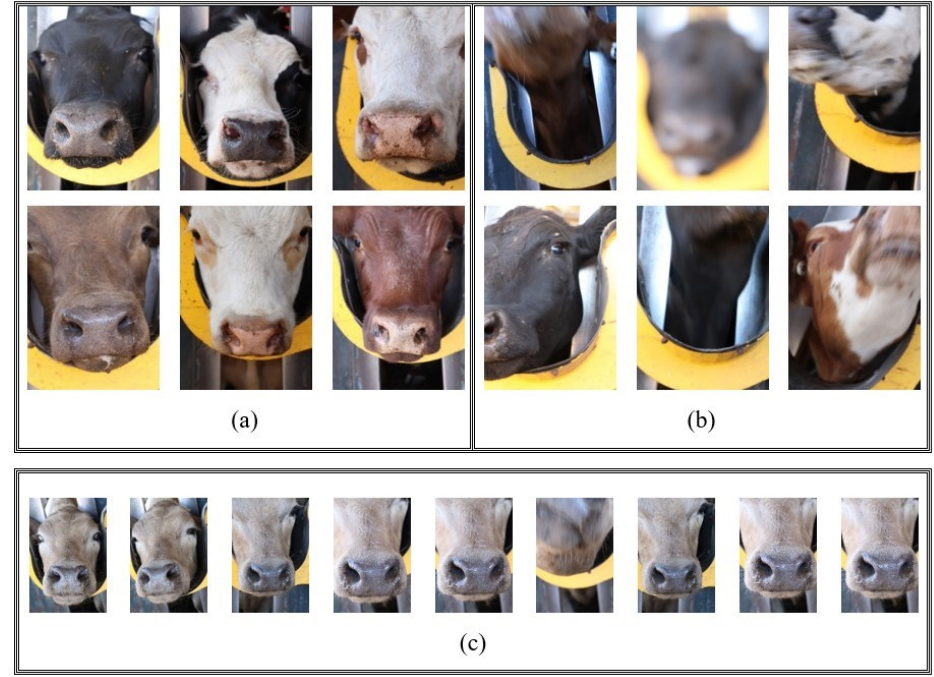
Figure 1. Samples of cattle face images: ( a ) acceptable images, ( b ) unacceptable images for biometric identification and ( c ) sample photos of an individual cattle demonstrating cattle head movement.